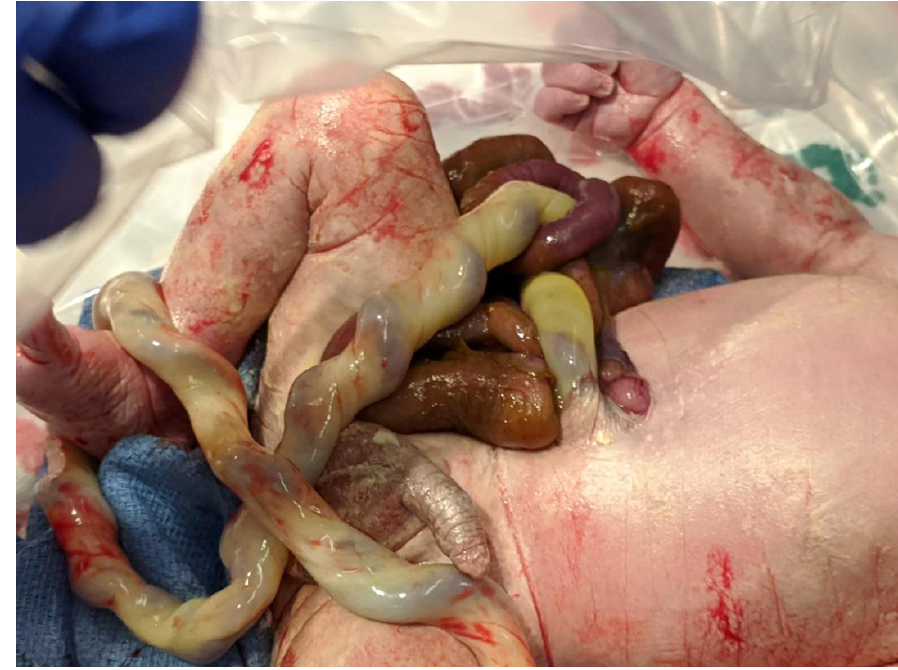
Figure 1. Term infant with simple gastroschisis. The picture shows a small abdominal wall defect to the right of the site of umbilical cord